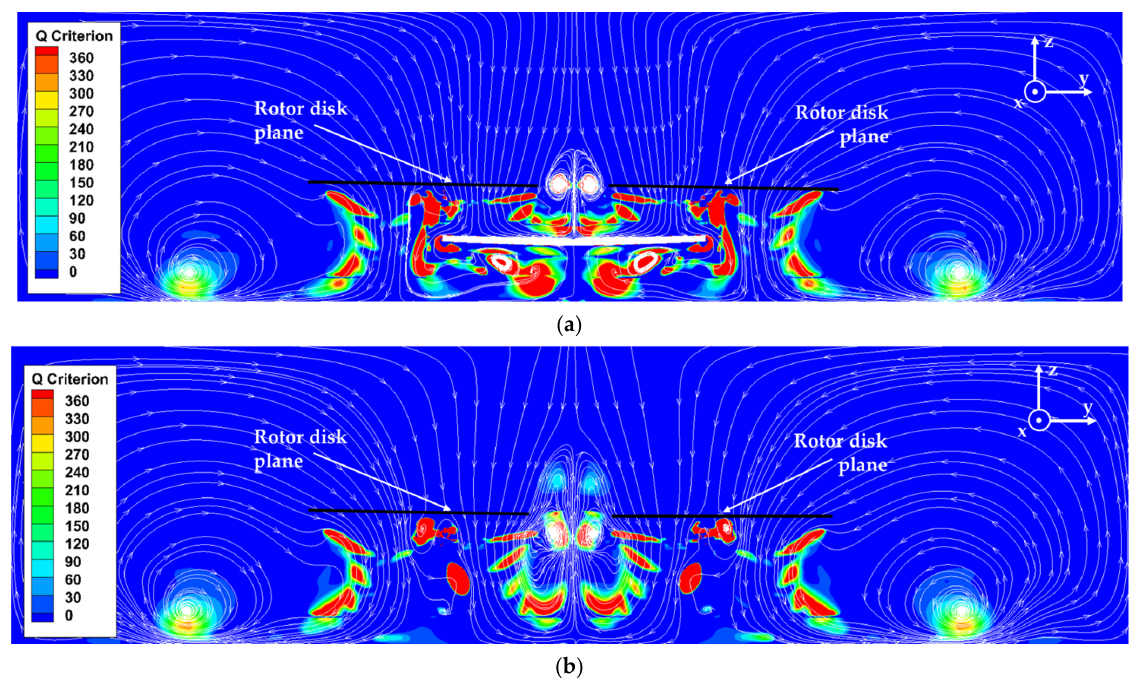
Figure 12. Streamlines and contours of the Q criterion at 1R height (front view): ( a ) 1R height, rotors with a wing; ( b ) 1R height, rotors without a wing.